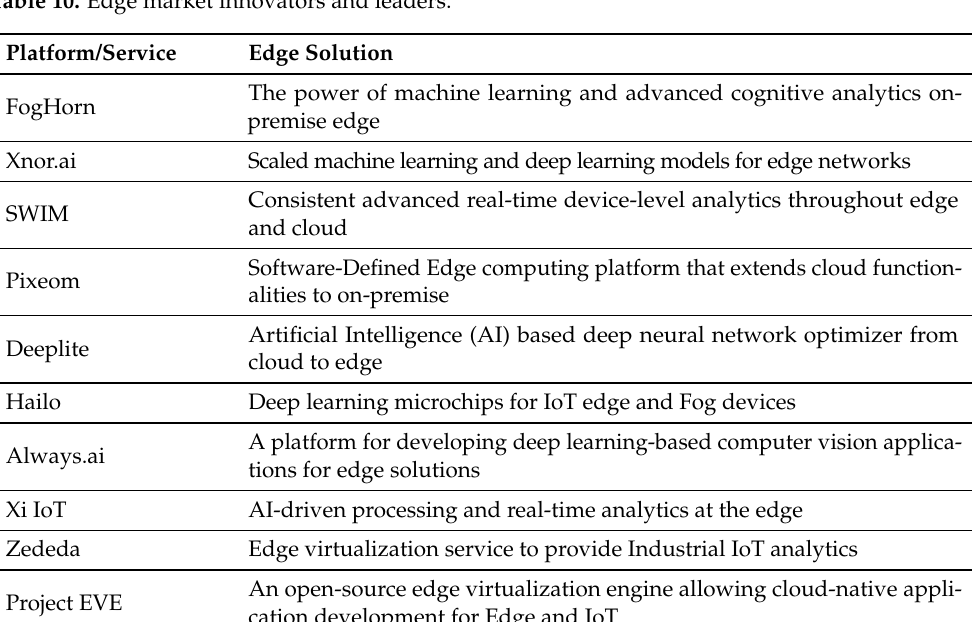
Figure 11. A multi-tiered Fog/Edge level architecture for the Internet of Things (IoT). Table 10. Edge market innovators and